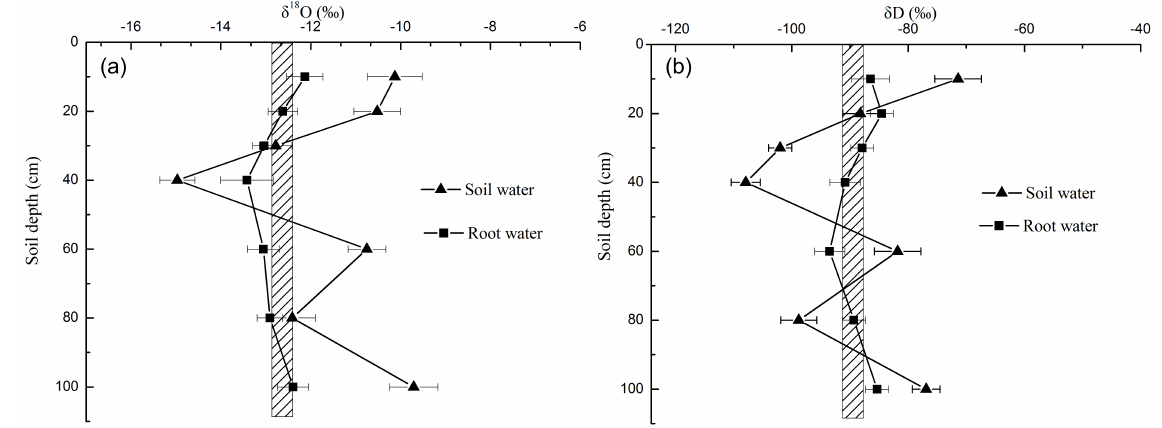
Figure 4. Isotope profiles of δ 18 O and δ D (preferential flow) in soil water and xylem water. Values are mean ± 1 standard deviation ( n = 27).